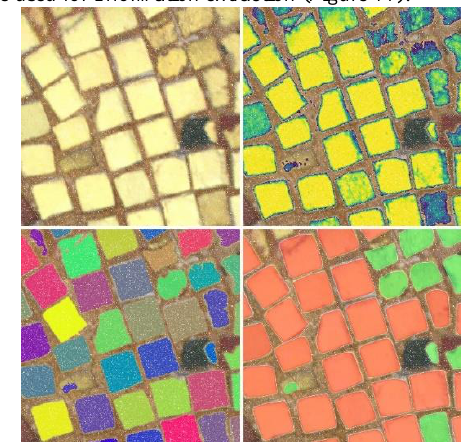
Figure 11 Point cloud from left to right, Colour, colour segmented, abstraction-based segmented, classified